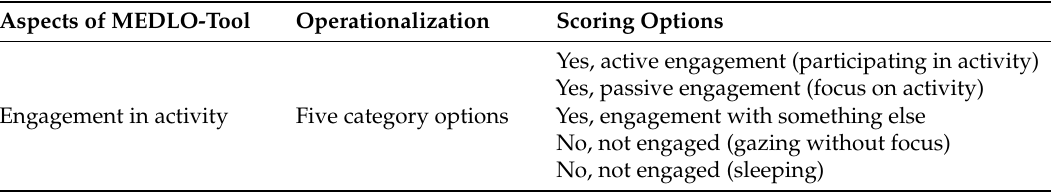
Table 3. Scoring options during